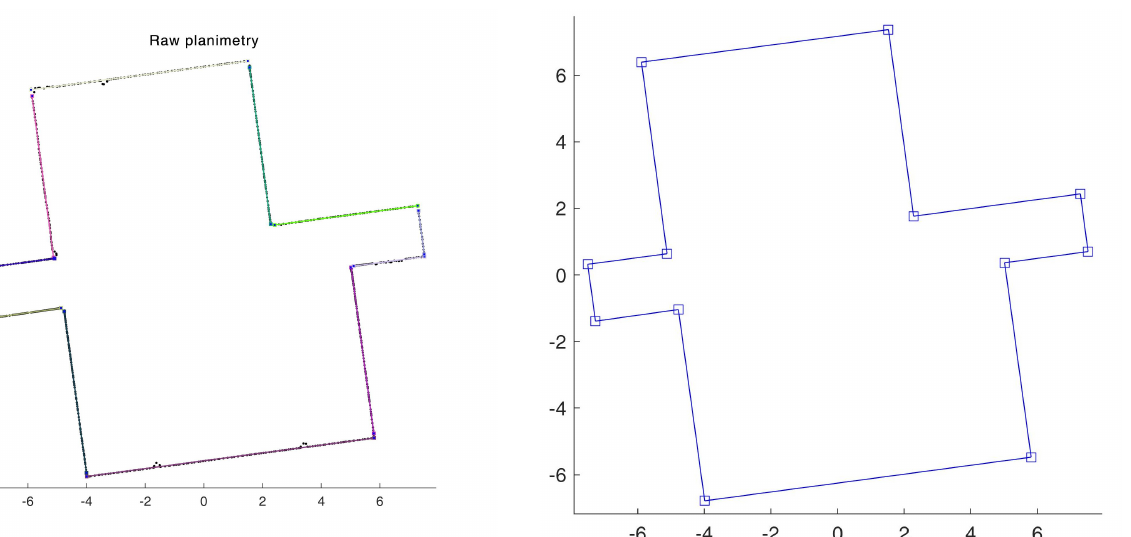
Figure 15: Raw layout.